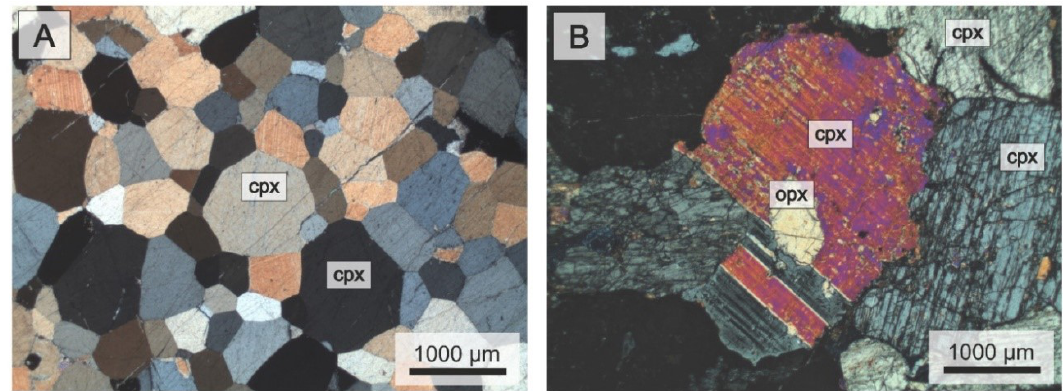
Figure 3. ( A ) Euhedral recrystallized clinopyroxenes displaying a granoblastic texture 1; ( B ) Twinned diopside with an enstatite inclusion (mineral abbreviations follow [68]).